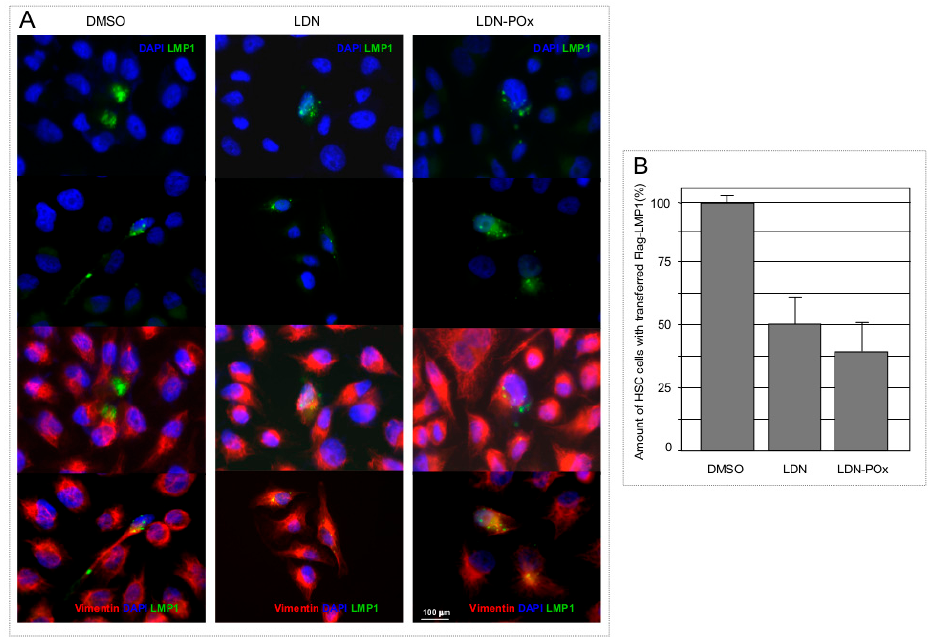
Figure 6. Both, free and micellated forms of UCH-L1 DUB inhibitor prevent extra cellular vesicles (ECVs)-mediated transfer of viral oncogene LMP1 to carcinoma cells. A . Two hundred and ninety-three cells were transfected with Flag-LMP1-expressing (vector) and 3 μ M of LDN or LDN-POx UCH-L1 inhibitors were added to the cells for 24 h. Extracellular vesicles (ECVs) from transfected and treated 293 cells were purified, as described in Materials and Methods. Growing HSC-3 cells were washed tree times with PBS and treated with ECV in fresh media with 10% fetal bovine serum (FBS) at ~70% confluence. Twenty-four hours later the cells were fixed in 4% PFA and co-stained with Flag and vimentin antibodies. Shown are representative images (4 ′ ,6-diamidino-2-phenylindole (DAPI) staining shows nuclei). B . LMP1-positive cells were counted in three random fields, and the results are presented as a percentage of HSC-3 cells with Flag-LMP1 transferred with ECVs. Scale bar: 100 μ m.